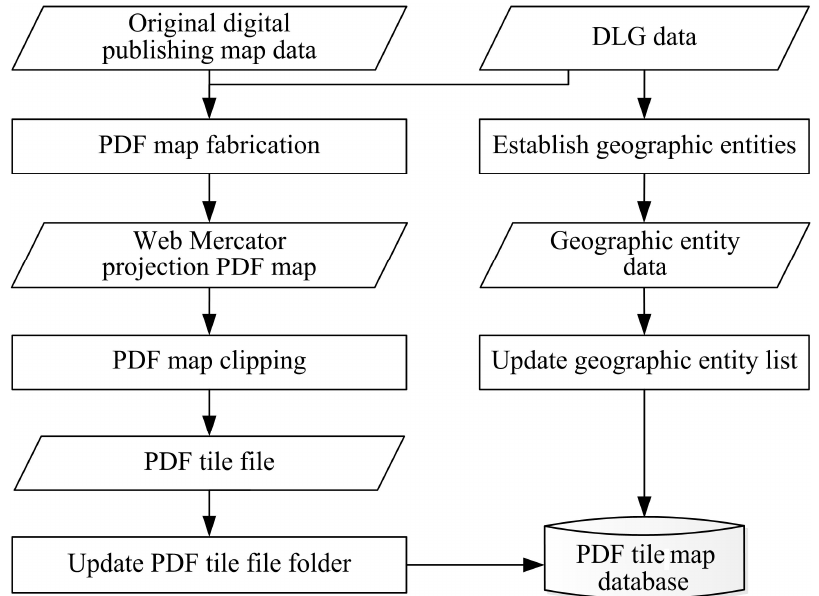
Figure 11. Dynamic generation and updating flowchart of PDF tile map. DLG (digital line graphic). Rectangular boxes denote data-processing operations. Parallelogram boxes denote data-processing results.